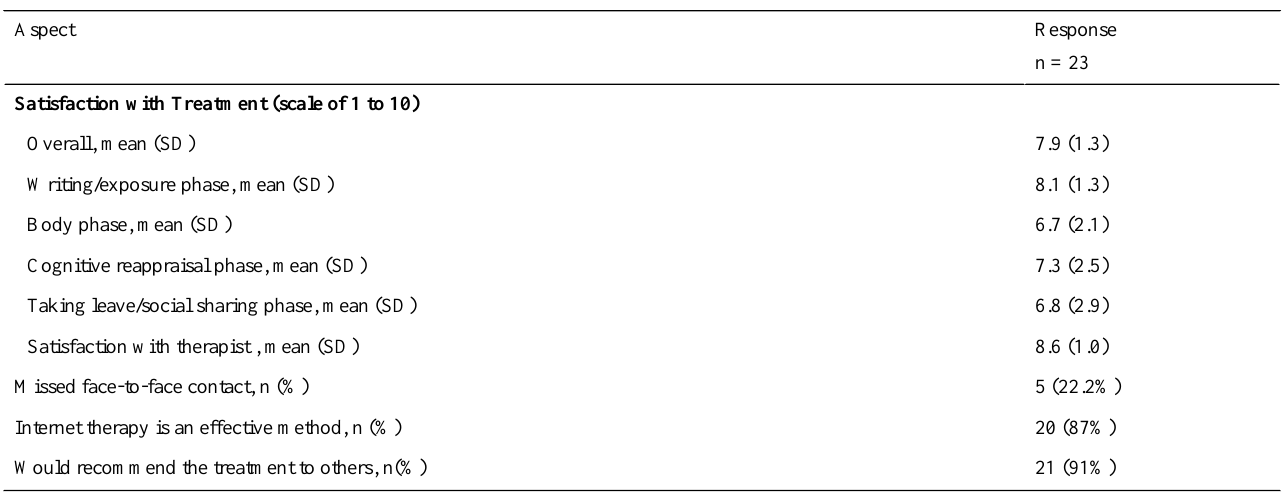
Table 3. Client satisfaction with treatment and therapists